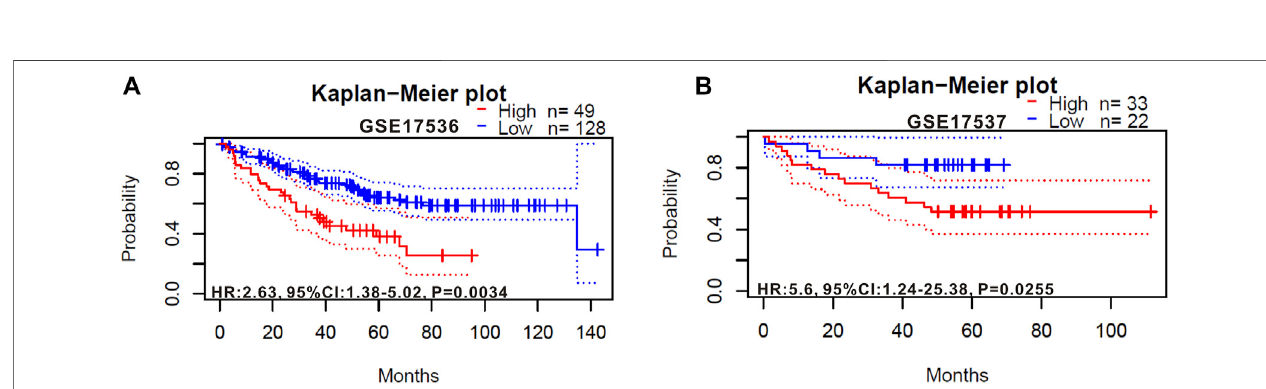
FIGURE 4 | Kaplan-Meier survival curves comparing the high and low expression of RIMKLB in colorectal cancer in the PrognoScan. (A) Survival curves of OS colorectal cancer cohorts of GSE17536 ( n = 177); (B) Survival curves of OS colorectal cancer cohorts of GSE17537 ( n = 55).